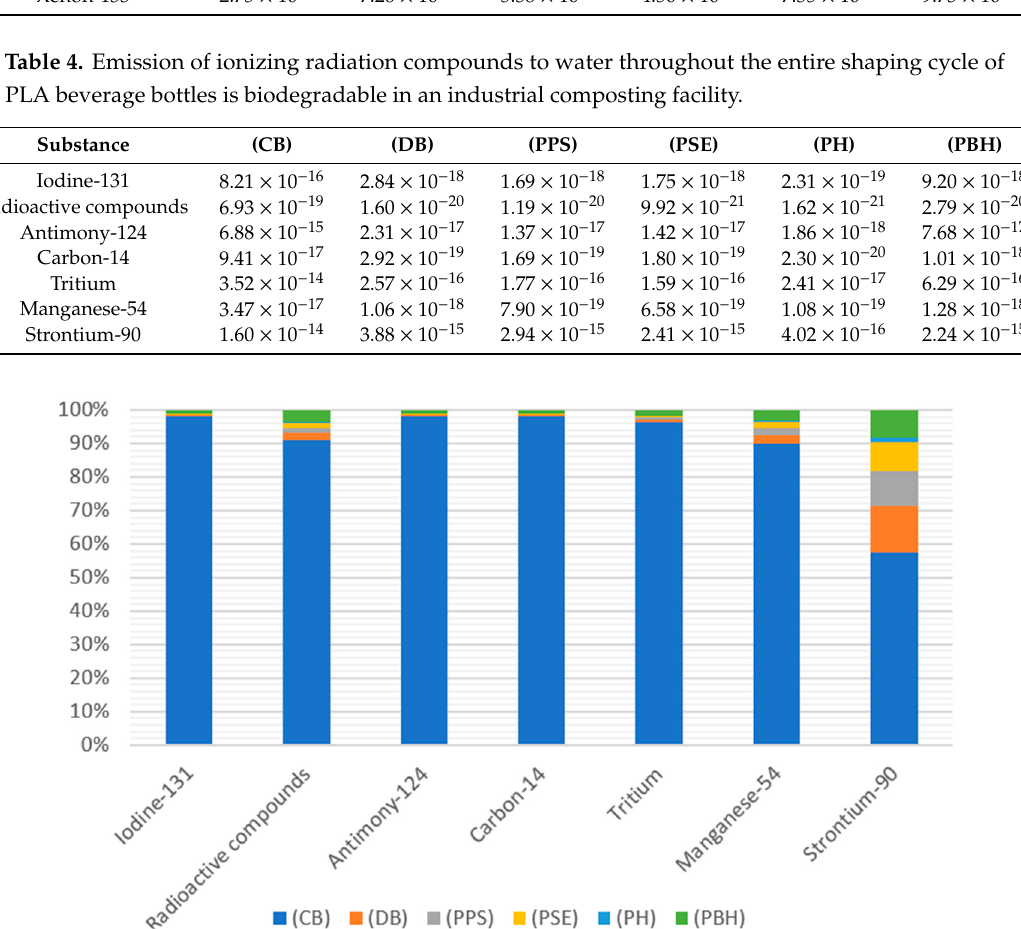
Figure 5. The results of characterizing the amount of ionizing radiation compounds emitted to water throughout the entire cycle of shaping bottles for beverages made of PLA which is biodegradable in an industrial composting facility.